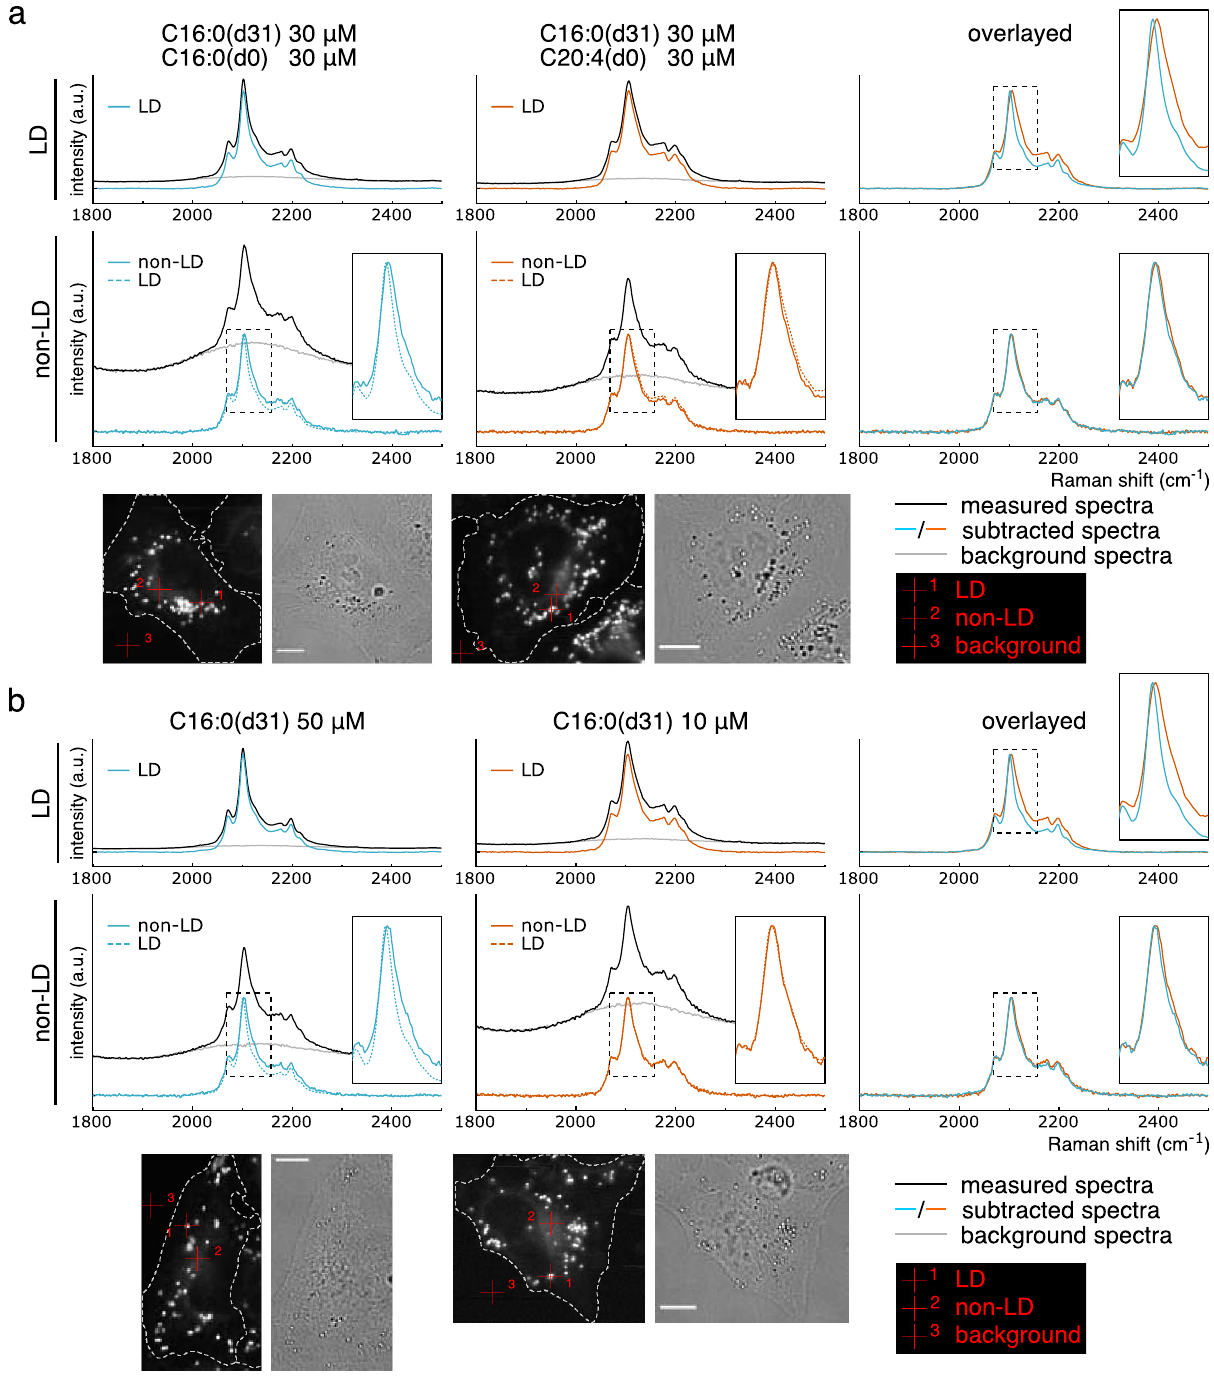
Fig. 3 Spectral transitions of C16:0(d31) in HeLa cells. a , b HeLa cells were treated with indicated concentrations of fatty acids or a fatty acid mixture, and the representative Raman spectra from C – D vibration were compared at LD and non-LD regions. Background spectra (gray lines) were subtracted from each measured spectrum (black lines) with the appropriate weightings (see Methods section for details) to illustrate a clear comparison, thus, producing subtracted spectra (solid blue or orange lines). Spectra from LD regions are also displayed with those from non-LD regions using dashed blue or orange lines at the bottom-left and bottom-middle graphs. Magni fi ed views of the dashed black boxes are shown in the inset of some graphs. Pixels of representative LD regions, non-LD regions, and pixels used for background spectra are represented by red crosshairs 1, 2, and 3, respectively, in the bottom images. Two independent experiments con fi rmed the results. Scale bars indicate 10 μ adjustments of the mixing ratio of these fatty acids, the in vivo showing various patterns depending on the sample positions. spectra of LDs in HeLa cells treated with the C16:0(d31)/ These results indicate that C18:1(d0) and C16:0(d31) were not C16:0(d0) mixture (blue lines in Fig. S4a) could not be fully mixed. In contrast, the LPC16:0(d31) and C18:1(d0) mixture reproduced. In addition, the reproducibility of in vitro spectra showed spectral changes similar to that of the PC mixture, also was poor when the C18:1(d0)/C16:0(d31) ratio was equal to 2, reproducing the in vivo spectra well (Fig. S4b). Nevertheless,